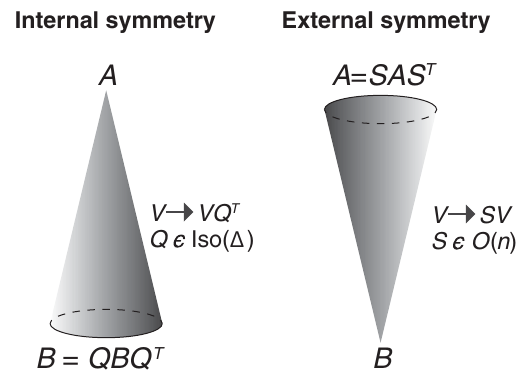
FIG. 2. Schematic representation of internal and external symmetries of the rank-reduction